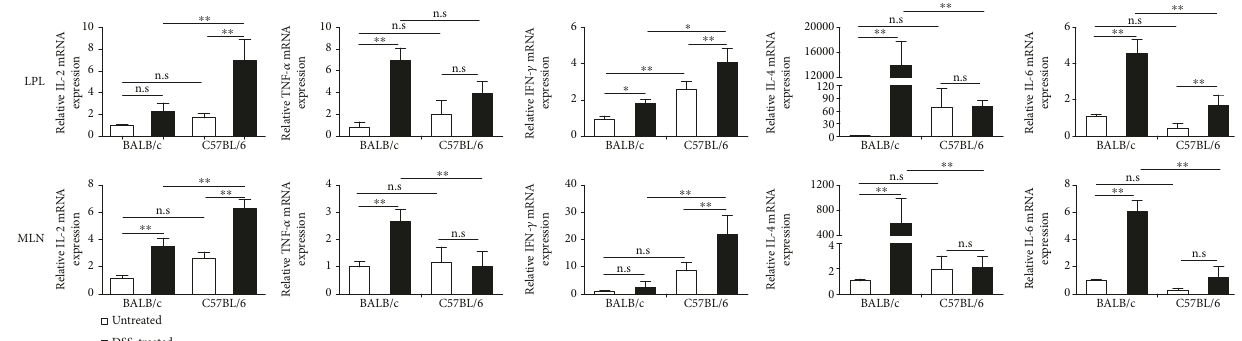
Figure 4: Real-time PCR determination of the cytokine mRNA expression of LPL and MLN following DSS challenge in BALB/c and C57BL/6 mice. Data indicate the mean ± SD obtained from a representative of two independent experiments each consisting of four animals. Statistical signi fi cant di ff erences were evaluated by Student ’ s t -test. ∗ p < 0 05 ; ∗∗ p < 0 01 . In all assays, the physical (day 0) cell number of immune cell subtypes is